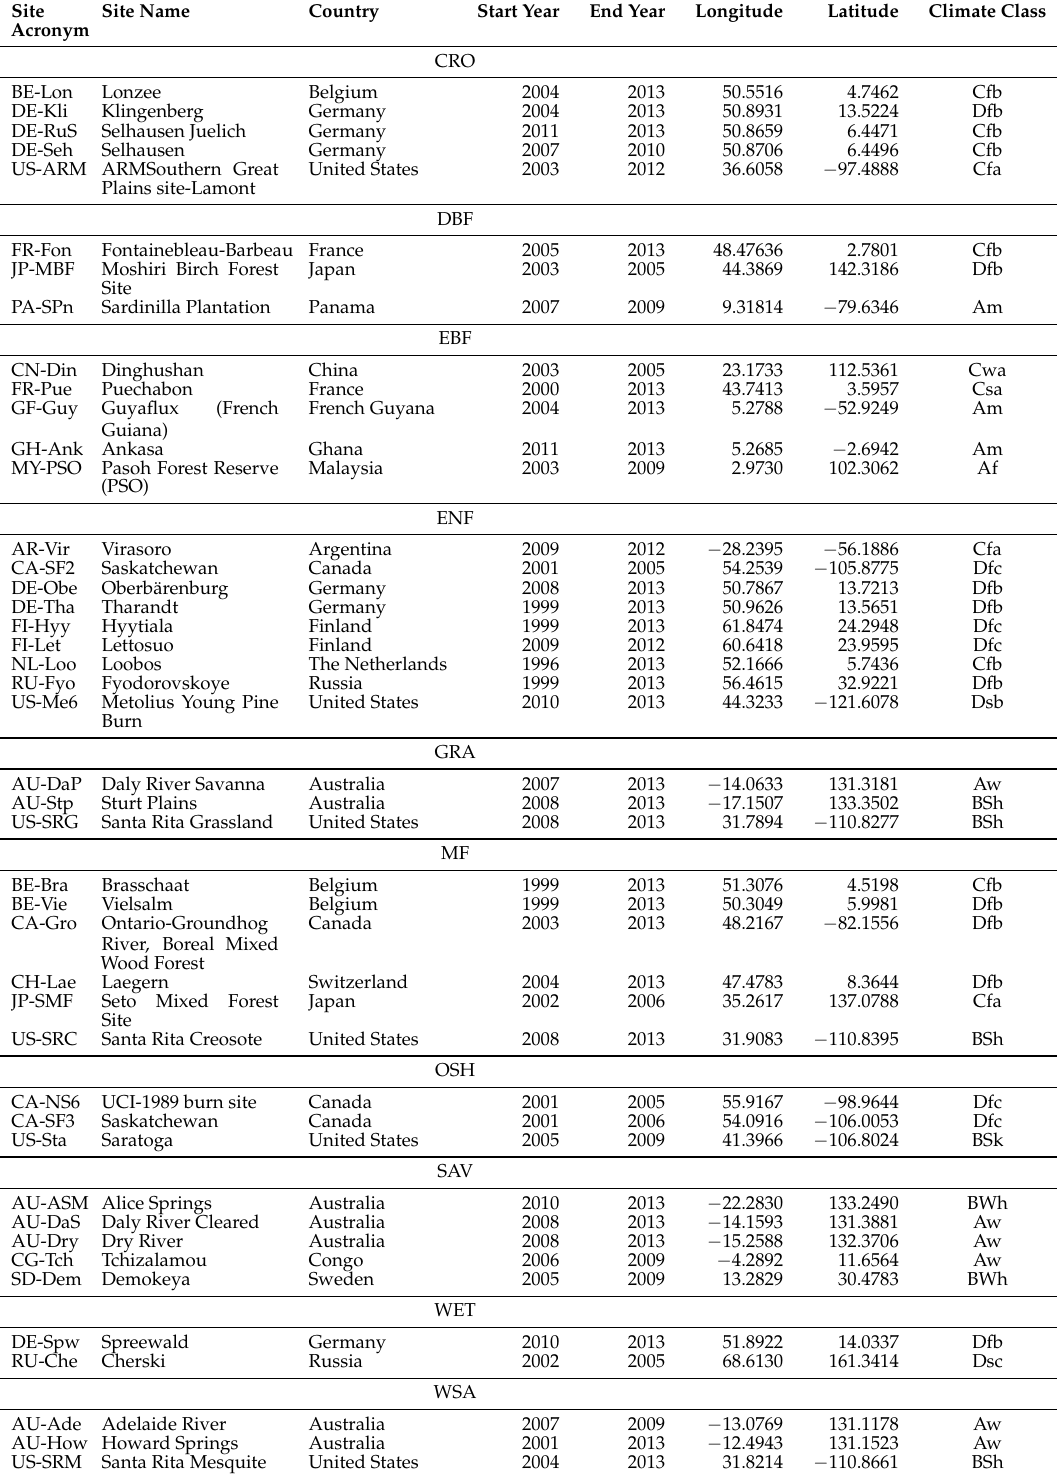
Table 1. Acronym, name, simulated period, location and Köppen–Geiger climatic class of the FLUXNET sites where ET simulations were performed. The studied sites are grouped by plant functional type where CRO = cropland, DBF = deciduous broadleaf forest, EBF = evergreen broadleaf forest, ENF = evergreen needleleaf forest, GRA = grassland, MF = mixed forest, OSH = open shrubland, SAV = savanna, WET = wetland, WSA = woody